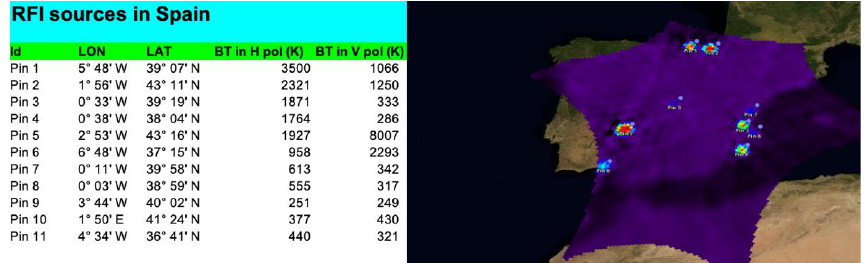
Figure 3. Example of a spreadsheet used as a database with information on RFI in Spain and a BT map corresponding to March 2010.